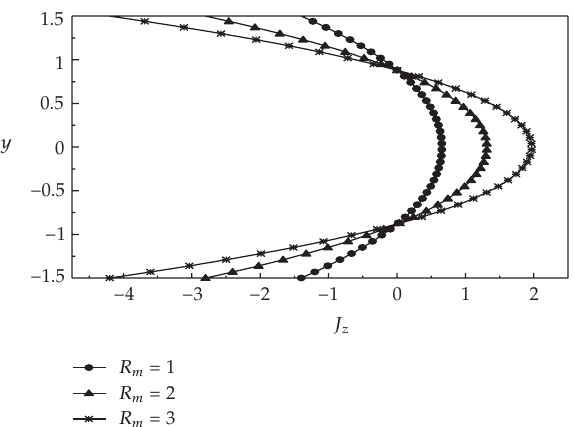
Figure 13: Variation of the current density distribution across the channel for α (cid:8) 0 . 5 , θ (cid:8) 1 . 6 , H (cid:8) 4 , m (cid:8) 3 , N (cid:8) 0 . 2, and di ff erent values of R m